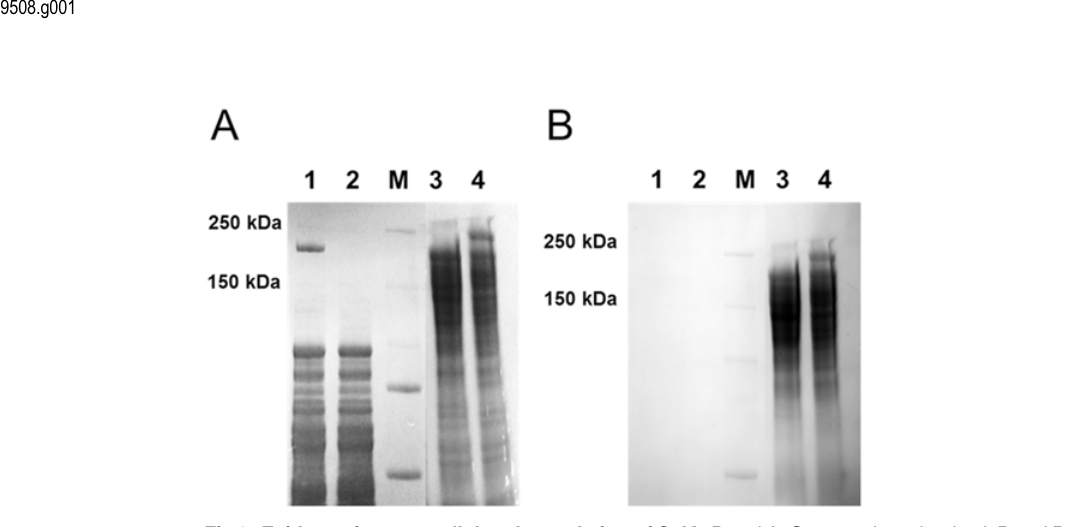
PLOS ONE | DOI:10.1371/journal.pone.0119508 March 23,